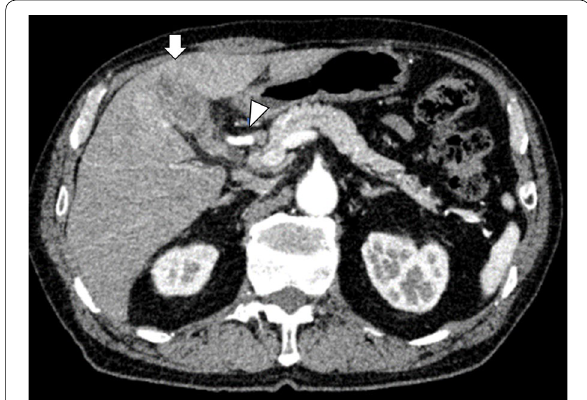
Fig. 1 Preoperative enhanced CT imaging of case 1. The arrow indicates the main tumor. The arrowhead indicates the right hepatic artery (RHA). A tumor of the gallbladder infiltrated to the liver parenchyma and spread to the cystic and common hepatic duct with contact of